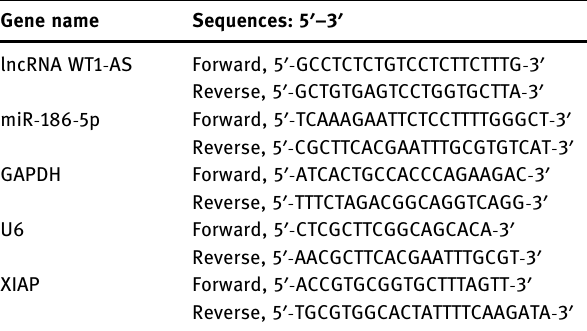
Table 2: Primer sequences for PCR Gene